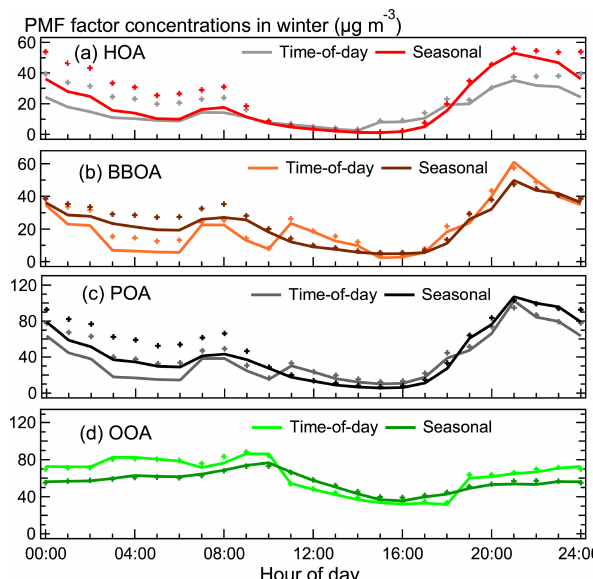
Figure 4. Seasonally representative hourly averaged diurnal mean ( + ) and median concentrations (lines) of (a) HOA, (b) BBOA, (c) POA, and (d) OOA in winter 2017 from time-of- day and seasonal PMF analysis. HOA exhibits stronger episodes than BBOA. OOA concentrations show limited diurnal variability in time-of-day PMF and seasonal PMF